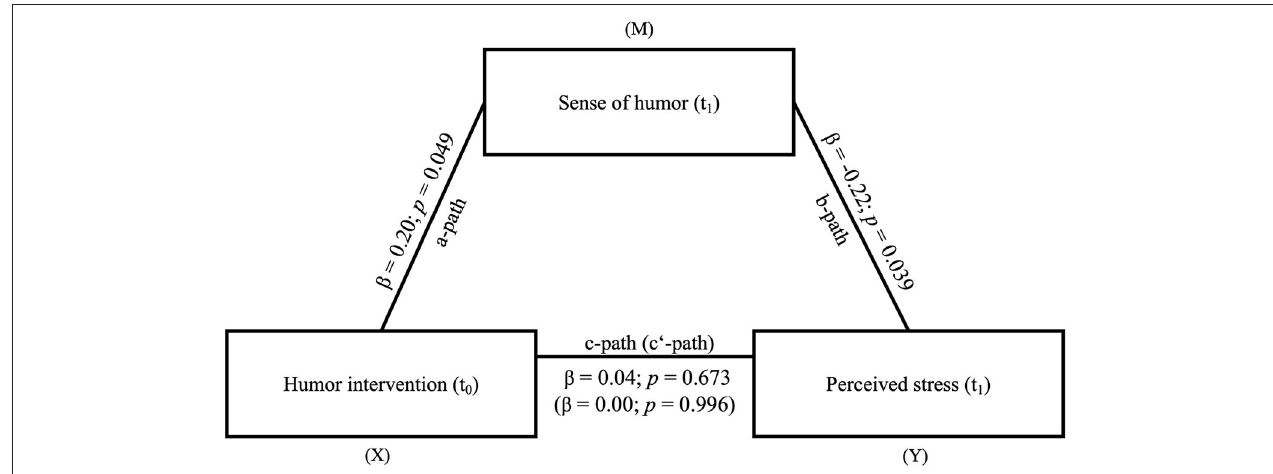
FIGURE 4 | Mediation model of the effect of the humor intervention (X) on perceived stress (Y) via sense of humor (M). N = 94. The indirect effect from (X = independent variable) to (Y = dependent variable) via (M = mediator) was significant ( β = − 0.04, SE = 0.03, − 0.11 < CI < 0.00); Measuring points: t 0 = Baseline; t 1 = 6 months after the humor intervention.